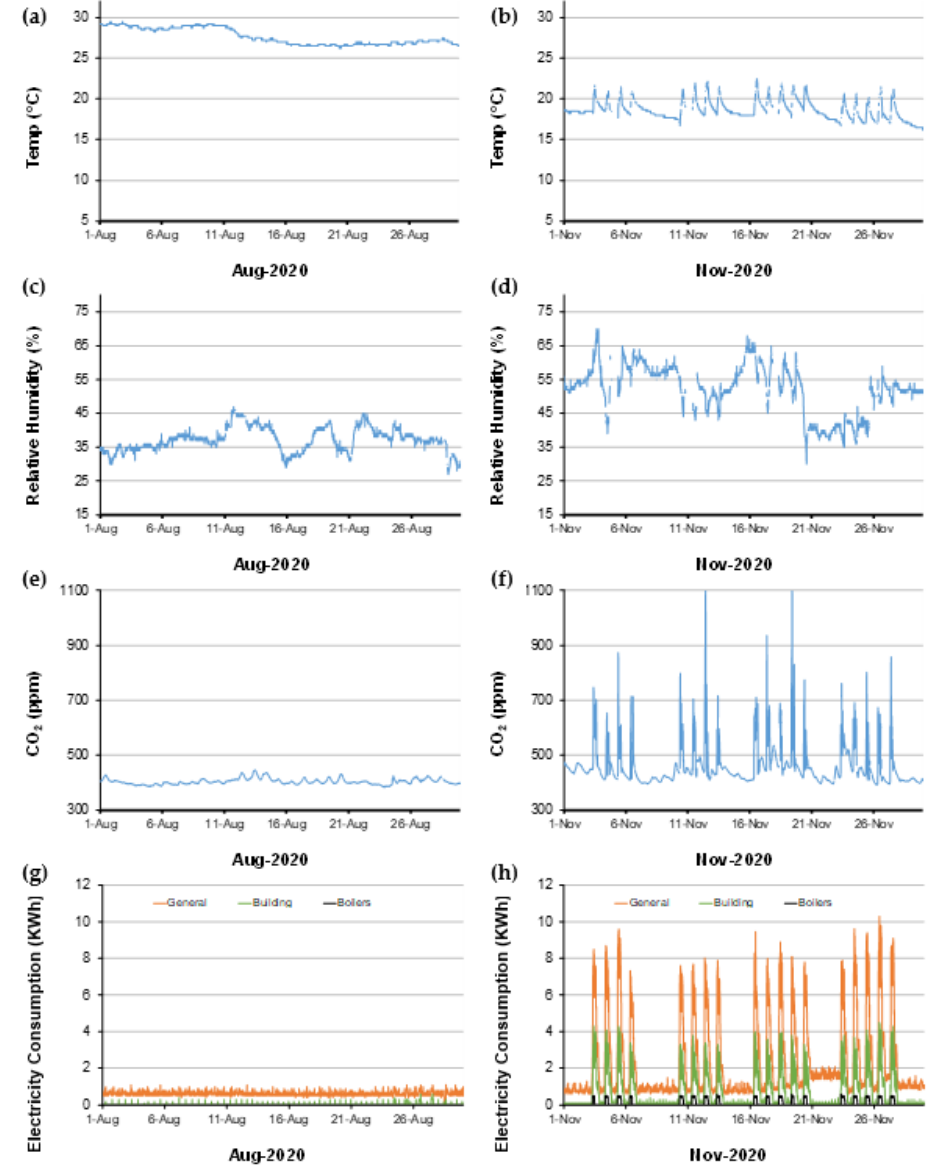
Figure 4. Overview of the typical monthly behavior of different variables assessed as possible indicators of occupancy status in schools, ), with ( a ), ( c ), ( e ), ( g ) data from vacation vs ( b ), ( d ), ( f ), ( h ) data from the scholar period.